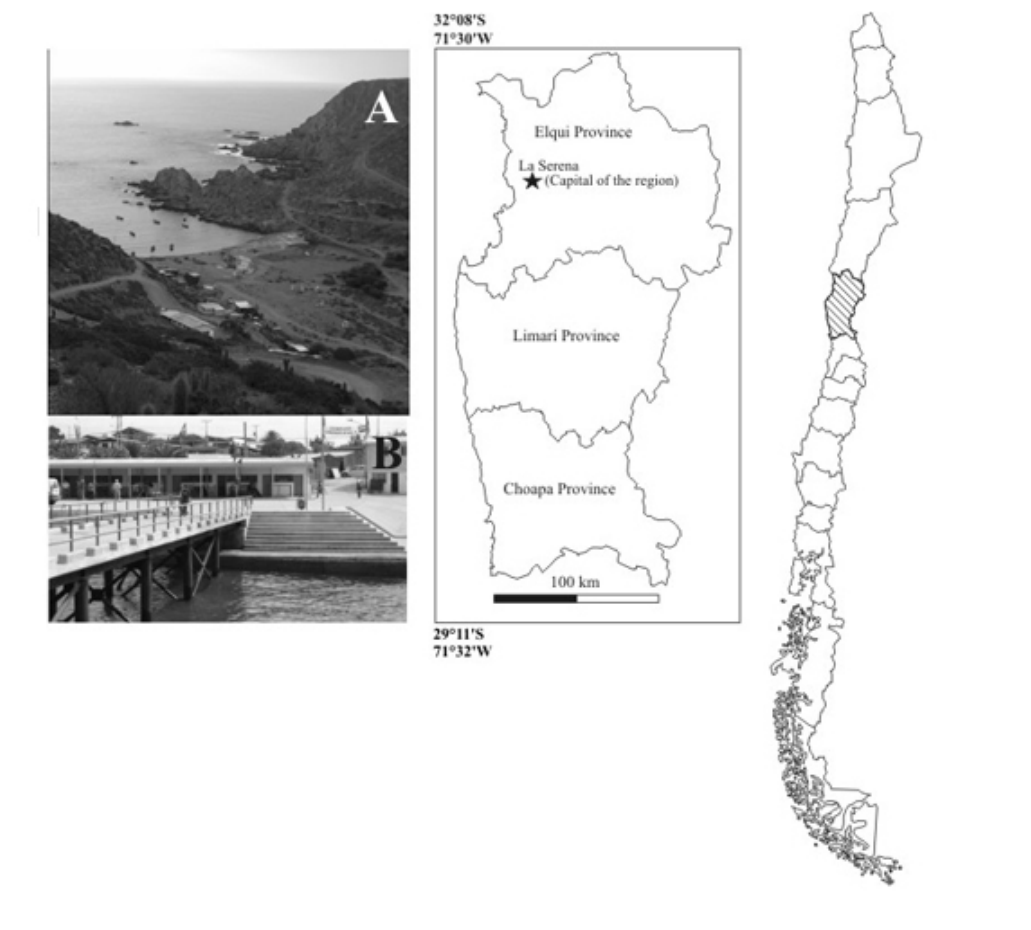
Fig. 1 . Location of the Coquimbo Region (Region IV) in Chile and its administrative division. The photographs show examples of “Caletas,” which are the landing sites of artisanal fisheries. (A) Caleta Sierra and (B) Caleta Totoralillo